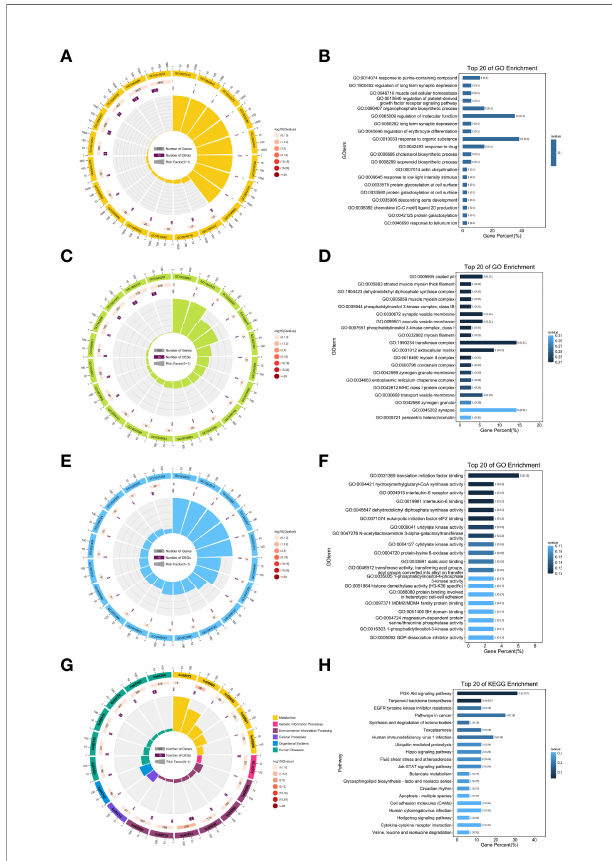
FIGURE 5 | Results of the GO and KEGG enrichment. Top 20 enrichment results (A, B) biological processes; (C, D) cellular component; (E, F) molecular function; (G, H) KEGG pathways